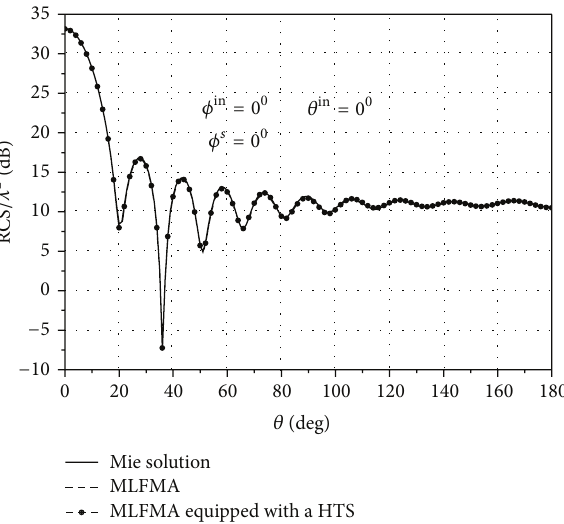
Figure 6: Bistatic RCS curves of the PEC sphere.